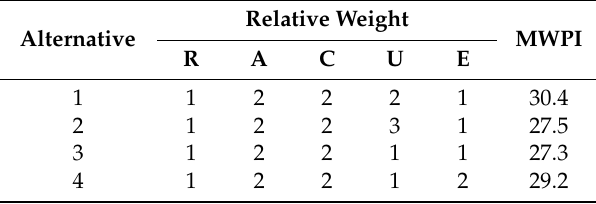
Table 2. Alternatives to equal weighting for the estimation of WPI in Golestan Province’s districts. Relative Weight Alternative